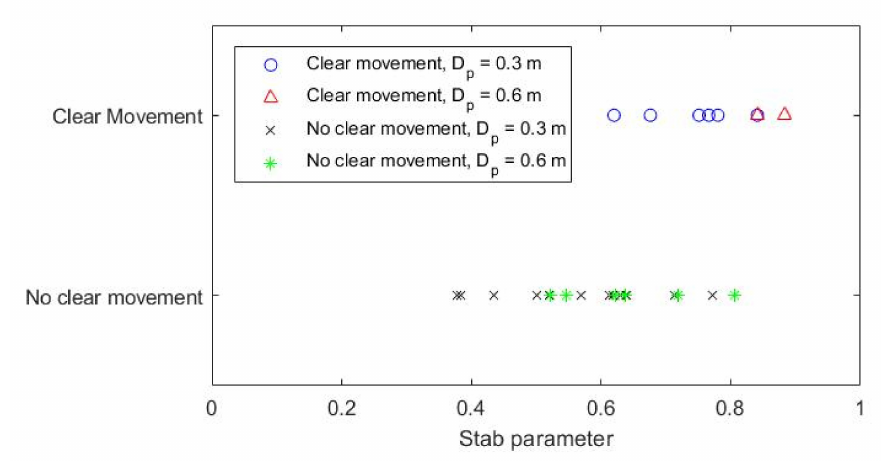
Figure 8. Relationship between the Stab parameter and the observed incipient of motion.